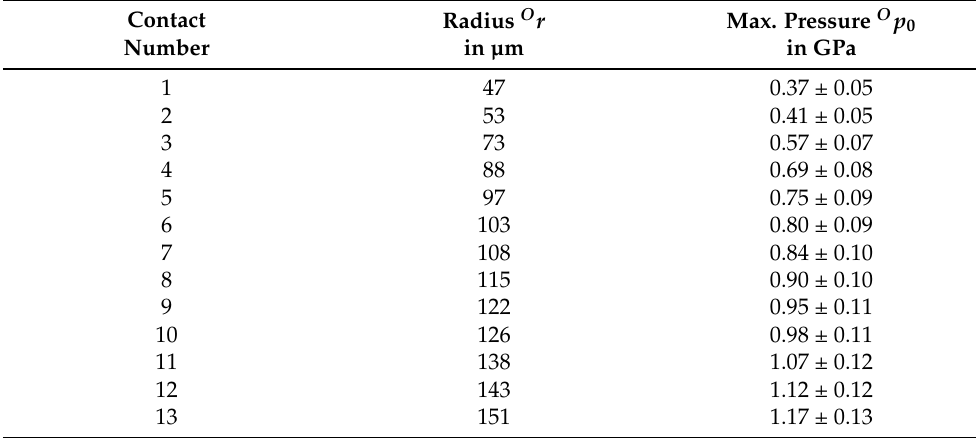
Table 3. Radius O r and maximum contact pressure O p 0 measured from the optical micrographs in the different contacts. The uncertainty of the radius is 1 µm.